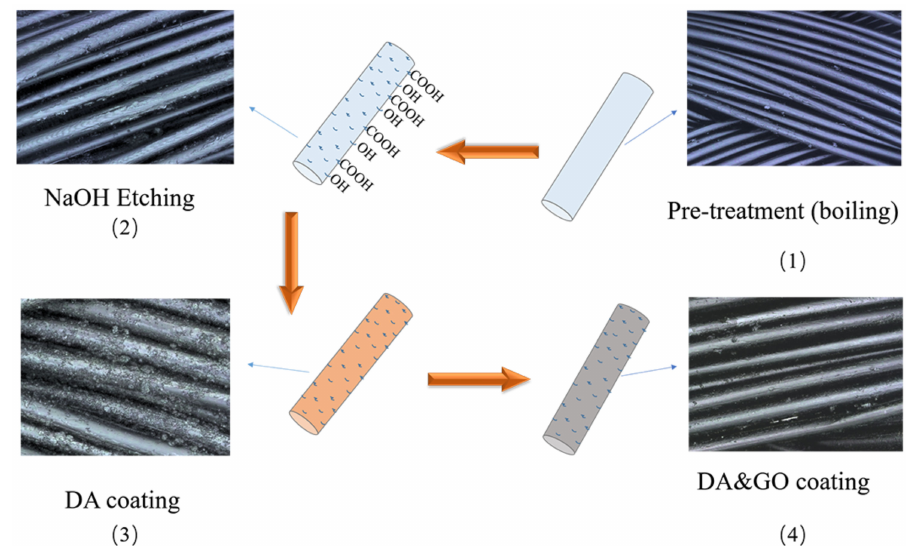
Figure 1. Schematic illustration of the coating process of polyglycolic acid (PGA) multifilament surgical suture. ( 1 ) Pre-treatment (boiling), ( 2 ) NaOH etching, ( 3 ) dopamine hydrochloride (DA) coating, ( 4 ) DA and graphene oxide (GO)